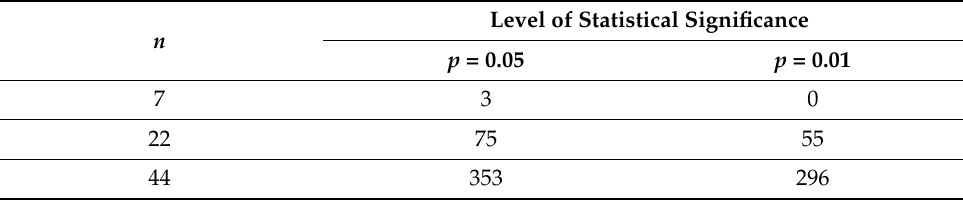
Table 15. The fragment of the table of T-Wilcoxon criteria, critical values (T cr. ) [89,93,94]. Level of Statistical Significance n p = 0.05 p = 0.01 7 3 0 296